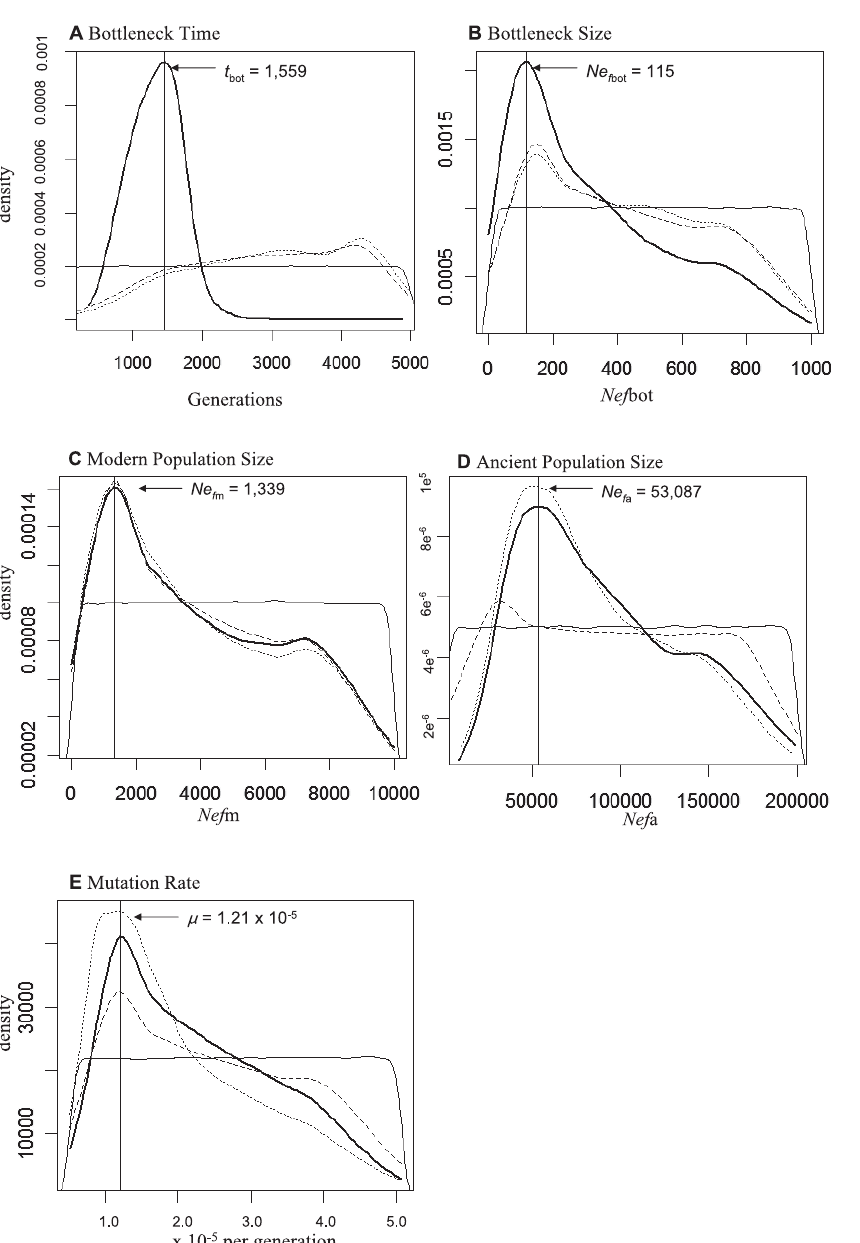
Figure 3. Posterior Density Curves of Model Parameters Based on 1,000 Accepted Values from 1,000,000 Iterations of the Bottleneck Model Thick black line is the posterior density curve of the bottleneck model which includes multiple time points, dashed line is the posterior based on modern data only, and dotted line is the posterior based on two time points, modern and ancient. The mode is indicated with a vertical line and labeled. Thin line is the prior density curve based on 1 million simulated values. (A) Bottleneck time in generations. Assuming a 2-y generation time the peak of the posterior density curve is at 3,118 ybp. Only multiple time points allow reasonable estimation of the bottleneck time. (B) Bottleneck